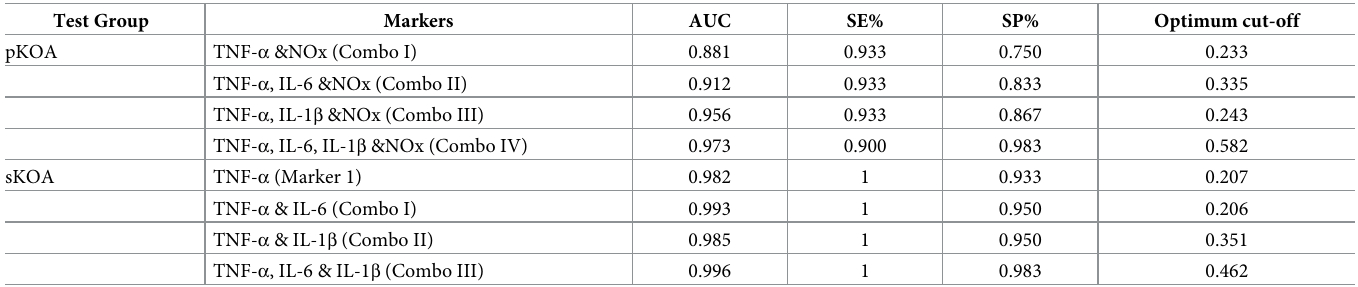
Table 3. The performance of individual analytes as gold markers or combination of markers via Receiver Operating Characteristic (ROC) curve analysis. Test Group Markers AUC SP% Optimum cut-off